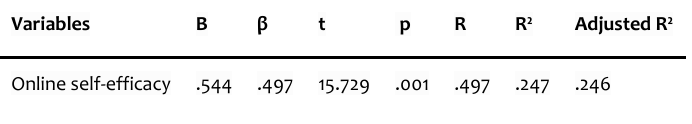
Table 1 . Regression analysis regarding the prediction of students’ online self -regulation